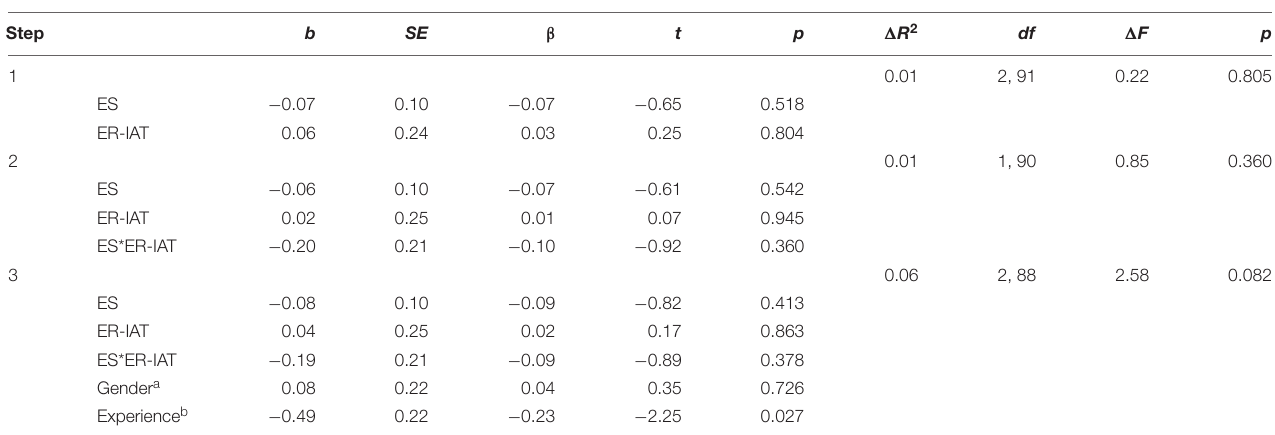
TABLE 8 | Results of the hierarchical multiple regression for Model